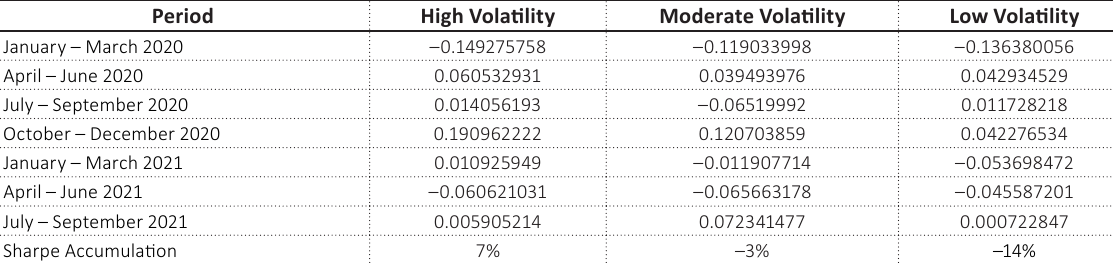
Source: Processed